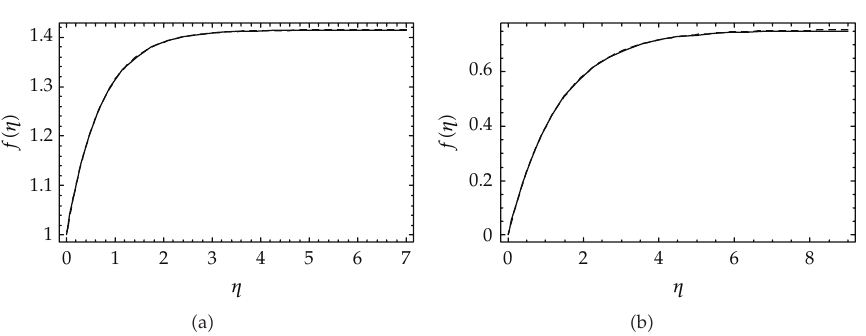
Figure 3: Profiles of the similar stream function f (cid:3) η (cid:4) as a function of η at m (cid:8) 1 for (cid:3) a (cid:4) s (cid:8) 1 , λ (cid:8) 0 . 5 and (cid:3) b (cid:4) s (cid:8) 0 , λ (cid:8) 1, solid and dashed lines are for ChPDM and G (cid:2) /G -expansion solutions, respectively.